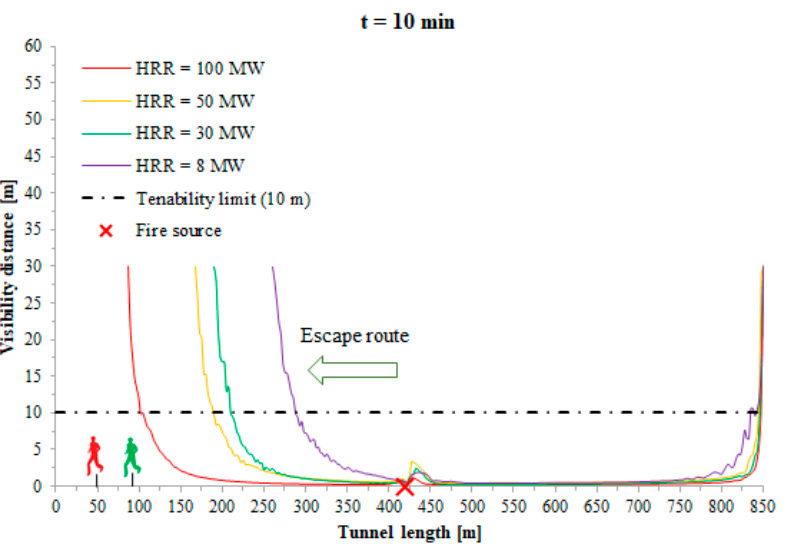
Figure 7. Longitudinal visibility distance profiles (t = 10 min) at a height of 2 m along the escape path when the fire source is in the middle of tunnel length.